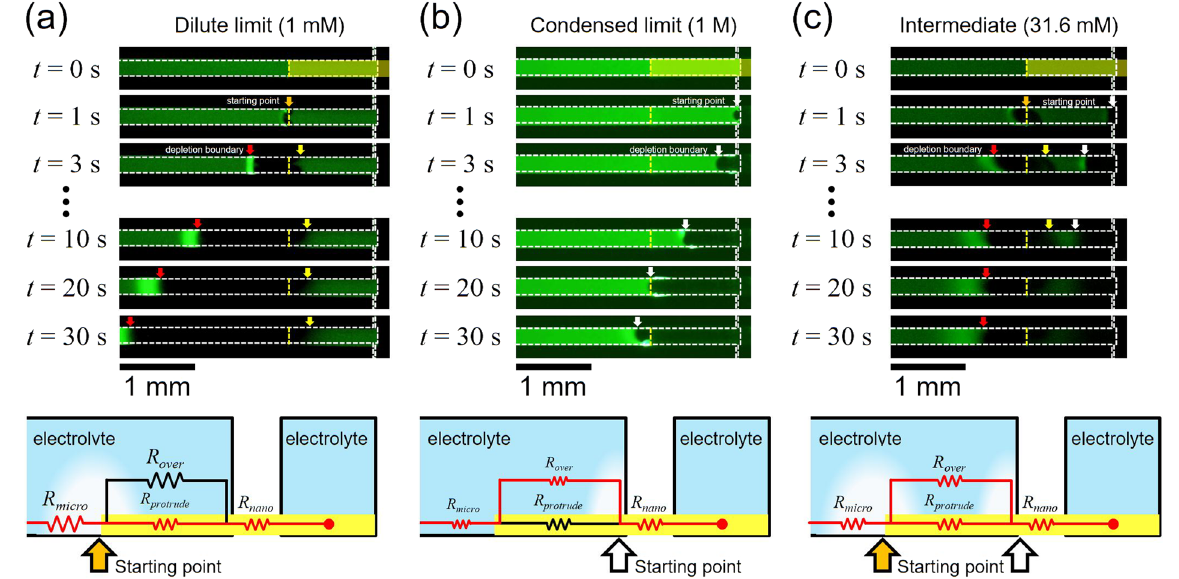
Figure 3. Time-revolving snapshots of propagating ion depletion zone (or ICP layer) at each concentrations with the applied voltage of 50 V; ( a ) Dilute limit (1 mM), ( b ) condensed limit (1 M) and ( c ) intermediate (31.6 mM). See supporting video for each figures. The schematic connections with the equivalent circuit were also given below each figures (not to scale). Red line indicated the dominant current